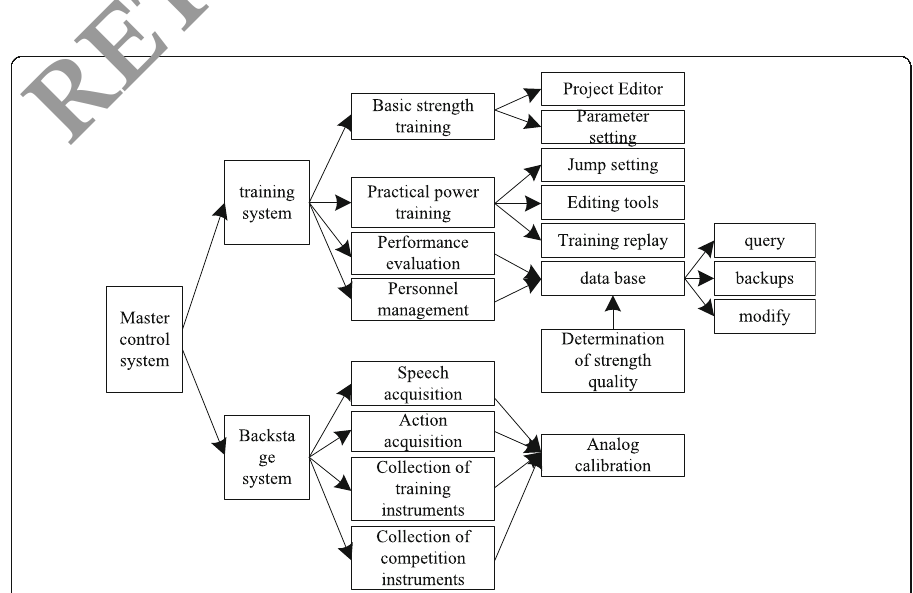
Fig. 4 Software structure of special movement strength training